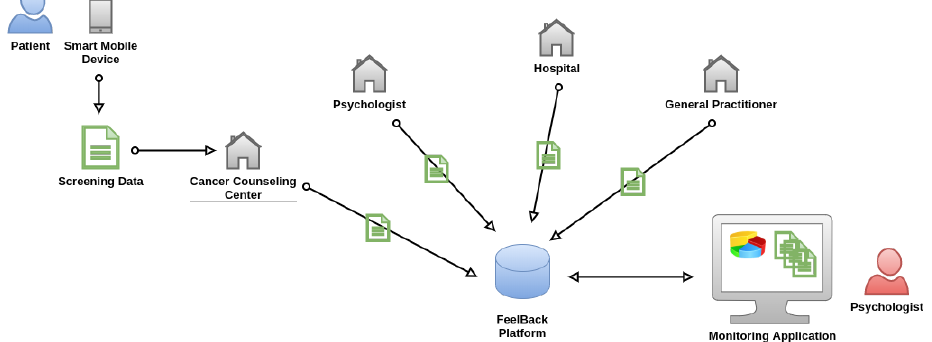
Figure 2. To-Be State of the Application Scenario. The FeelBack-platform allows for centralizing patient information in the context of psychological distress. After registration, the data collected are independent of the involved health care provider. The data are directly transmitted to a centralized hub (FeelBack platform) in a pseudonymous way. In addition, involved health care providers can add data to health record of the corresponding patient at the centralized hub. This platform allows psychologists to access data that are always synchronous and up-to-date via a monitoring